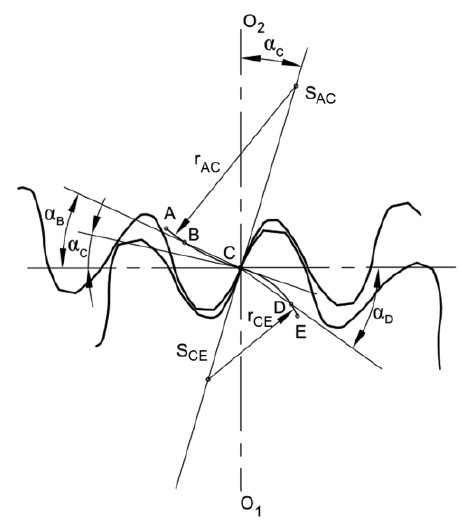
Figure 1. Characteristic points and geometric parameters of the convex–concave gearing.